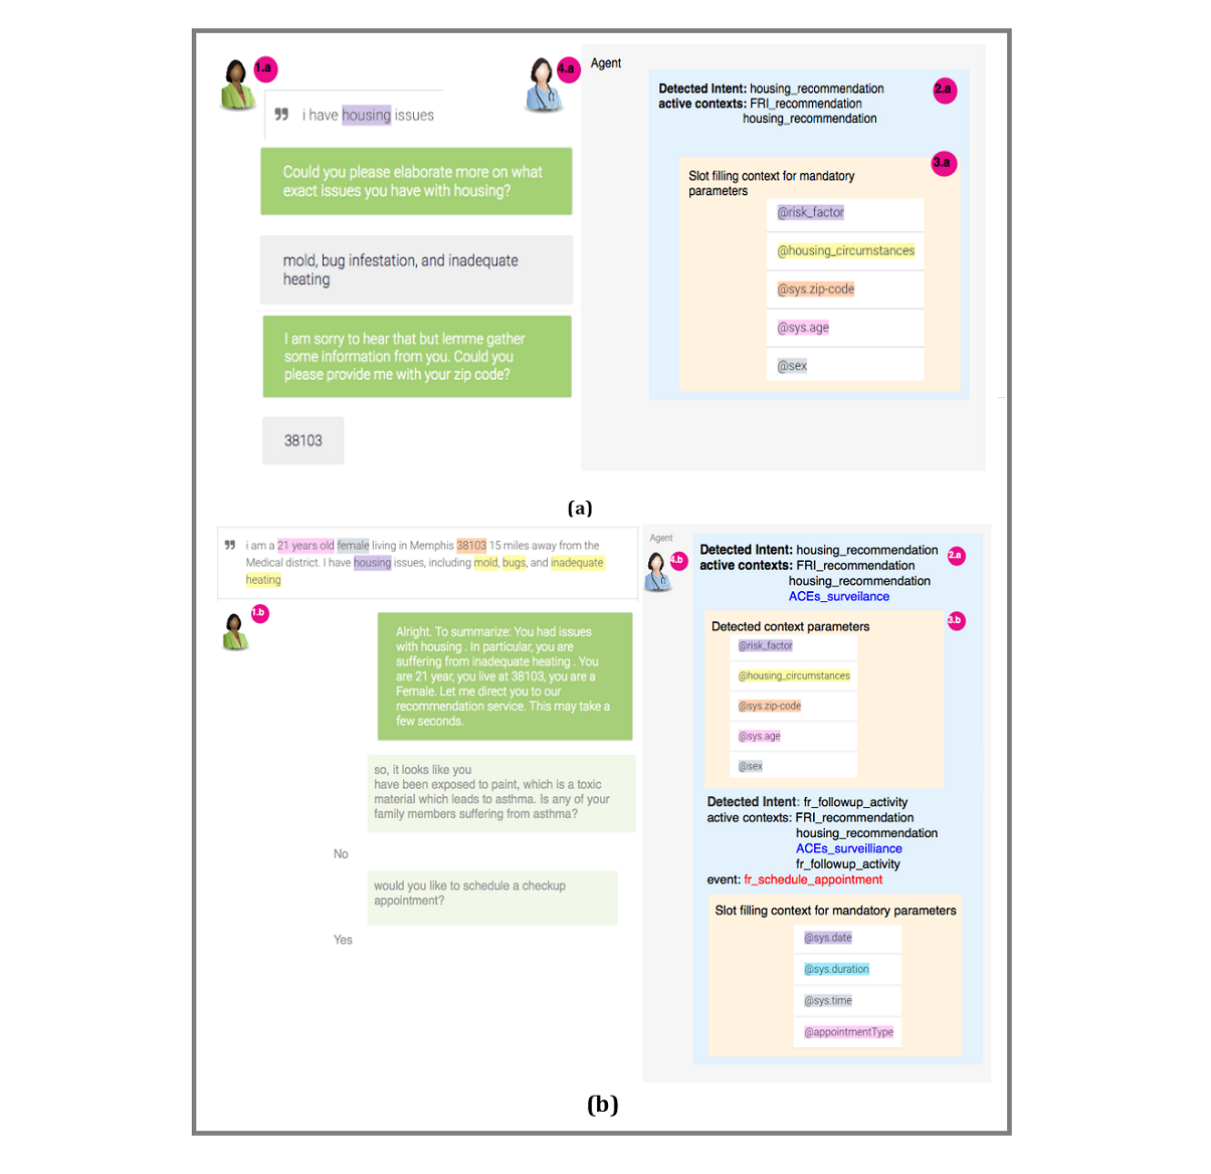
Figure 5. Two scenarios for conversation flow. (a) Scenario 1: client does not provide much detail and is prompted with mandatory parameters asked in a certain order. (b) Scenario 2: The client provides details for mandatory parameters. Since the user’s text contains lead-based paint, the agent makes a hypothesis that a household member might need an early diagnosis for asthma based on the fact that lead-based paint is a toxicant and that exposure to toxicants may lead to asthma. The parameter values get substituted at run time and more intents get detected while active contexts remain and new contexts get added. To keep track of where the user is in the conversation, the agent keeps track of all active contexts on a